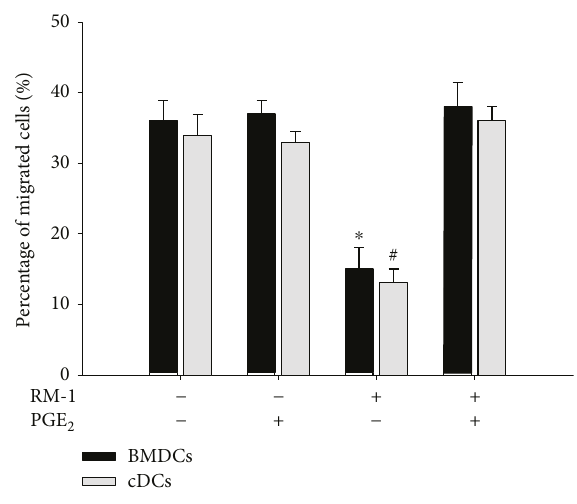
Figure 3: PGE improves DC migration in vitro. DCs were 2 activated by the inclusion of 10 ng/ml LPS culture in the presence or absence of conditioned medium from the RM-1 as well as PGE . Quanti fi cation of the migration of DCs to 200 ng CCL19. 2